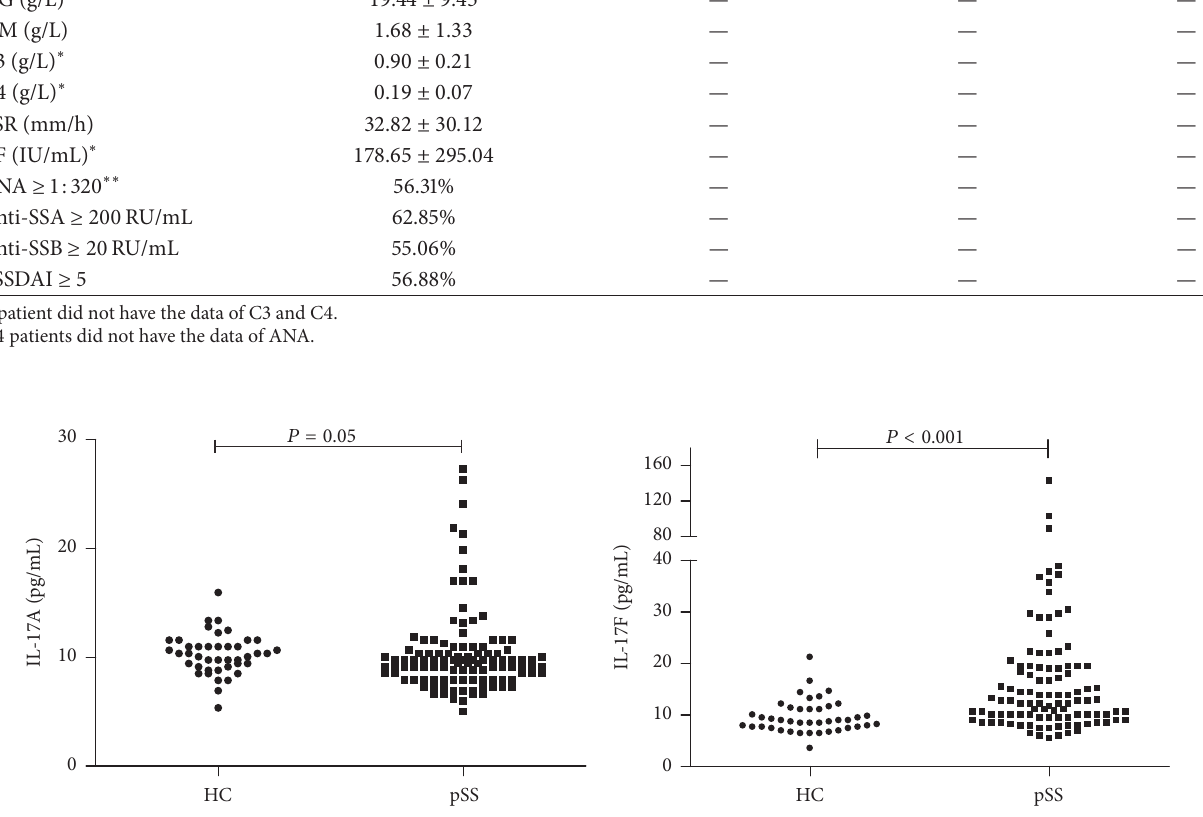
Figure 1: Comparison of serum levels of IL-17A and IL-17F between pSS patients and HC. (a) Serum IL-17A levels were not significantly elevated in pSS patients versus HC. (b) Serum IL-17F levels were significantly elevated in pSS patients versus HC.